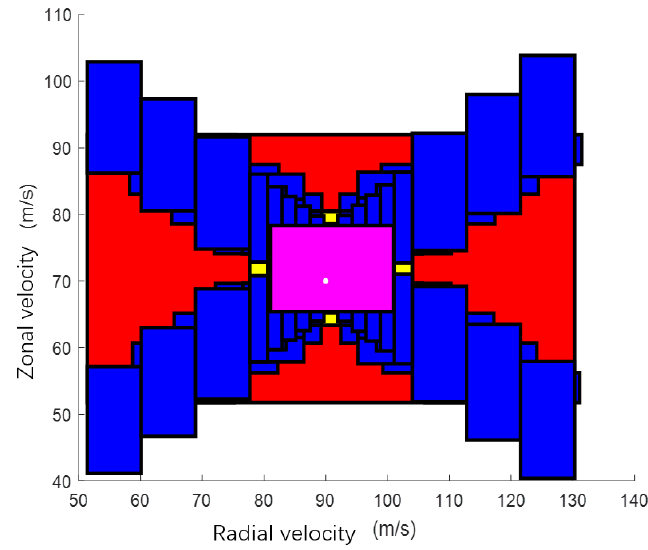
Figure 5. The final velocity estimation interval of the algorithm.